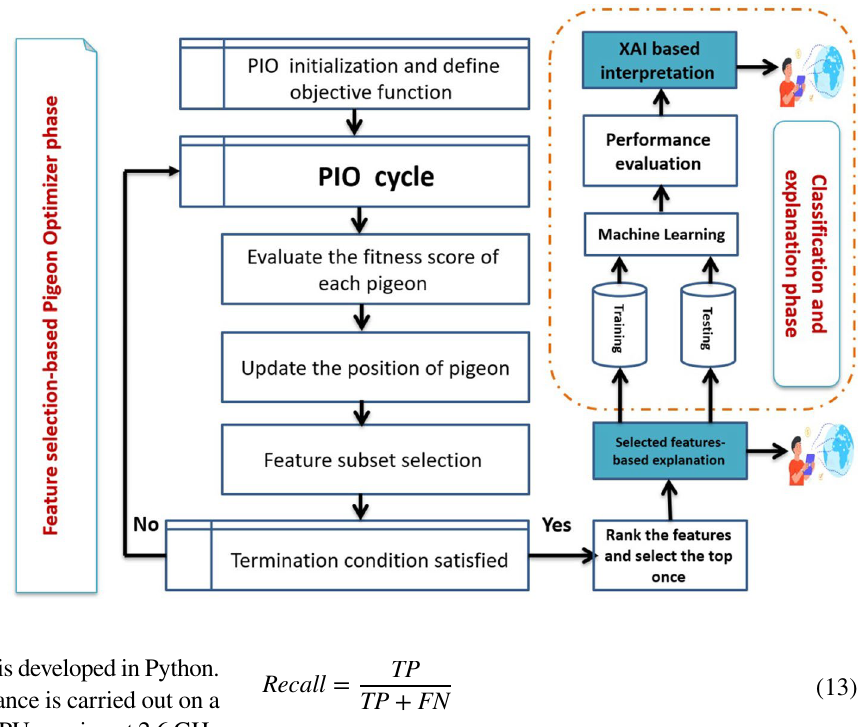
Fig. 3 The feature selection pro- cess based on the PIO algorithm and XAI